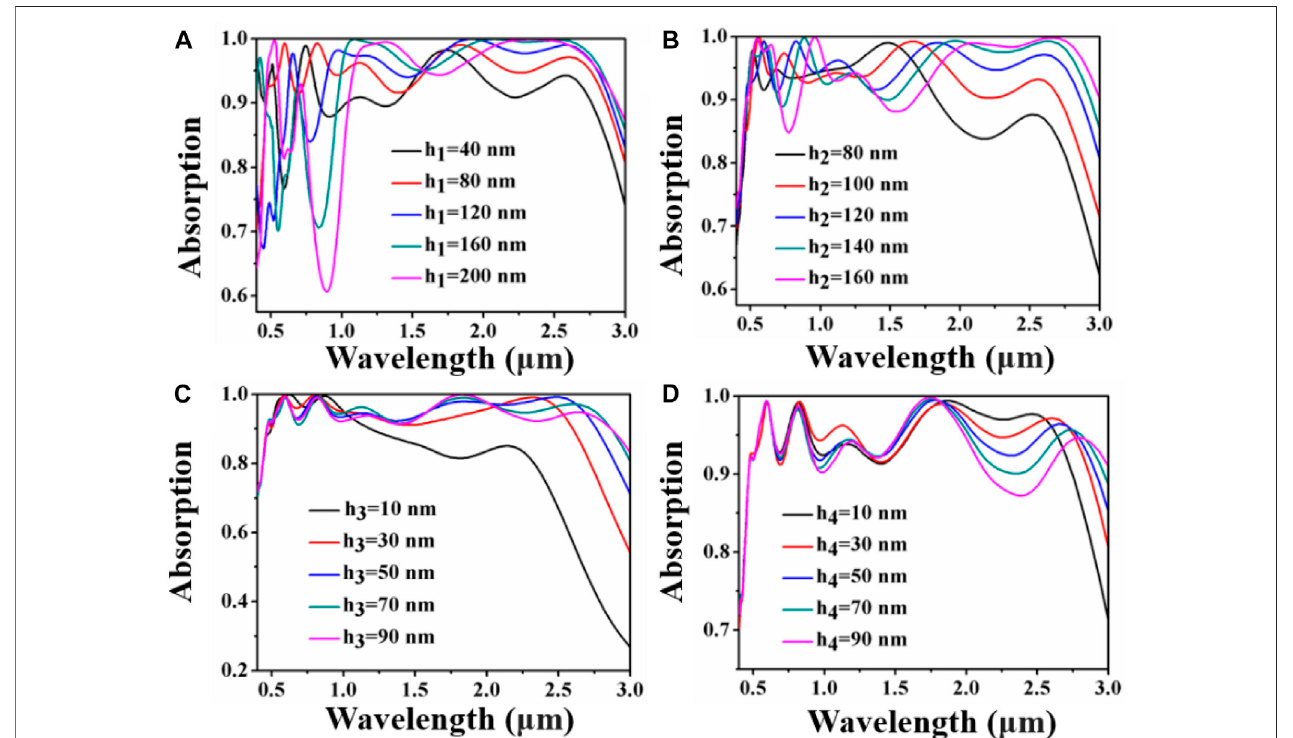
FIGURE 3 | (A – D) Absorption spectra corresponding to different geometric